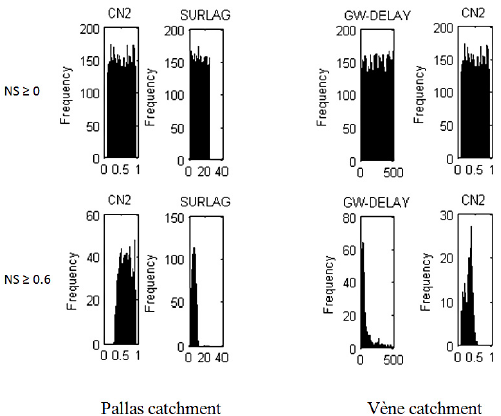
Figure 4. Example of the effect of the threshold value on the poste- rior parameter distribution derived from